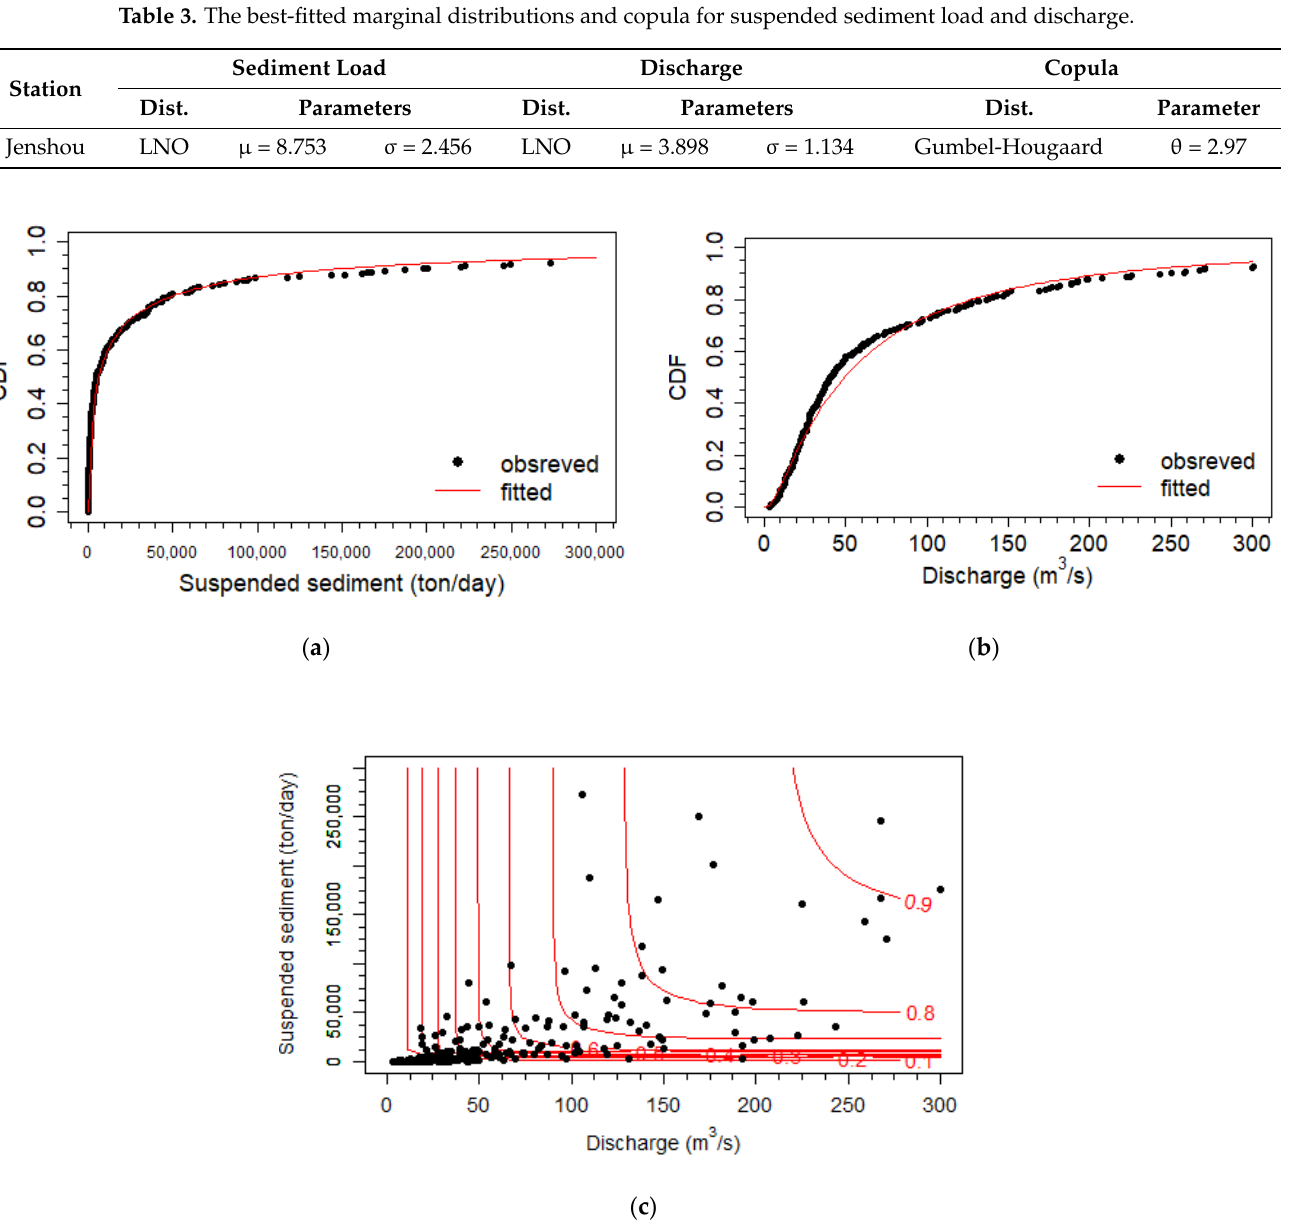
Figure 2. ( a ) Fitted lognormal distribution associated with recorded suspended sediment load, ( b ) fitted lognormal distribution associated with recorded discharge, ( c ) contour plots of joint CDF of sediment and discharge by Gumbel-Hougaard copula and recorded paired data at Janshou station for the period of 1960 − 2000.